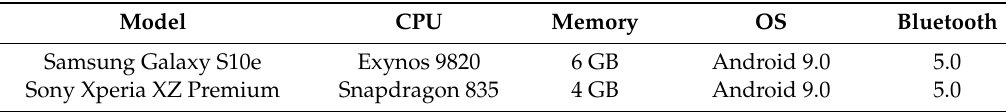
Table 1. The smartphones used for the experiment.